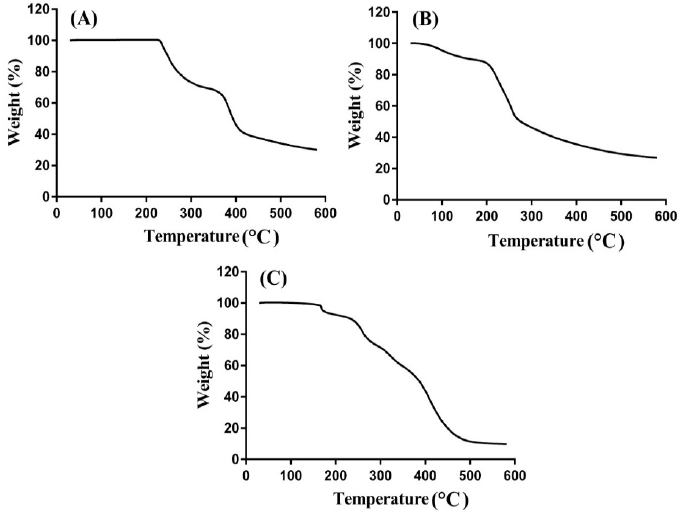
Figure 5. TGA of ( A ) Aspartic acid (ASP), ( B ) Alginate (AL), and ( C ) ASP/ALPAA hydrogels.